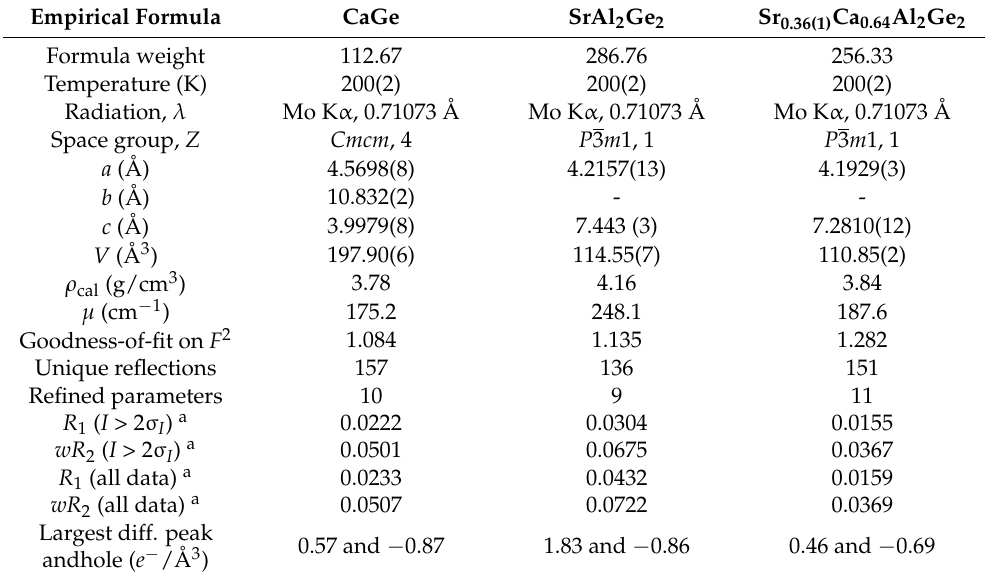
Table 1. Selected single-crystal data collection and structure refinement parameters for CaGe,